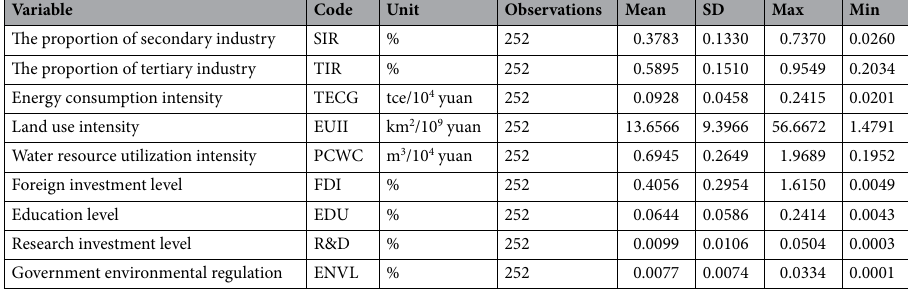
Table 2. Explanation of each explanatory variable and its descriptive statistical analysis. The value and quantity indicators in the table are all converted into constant prices in